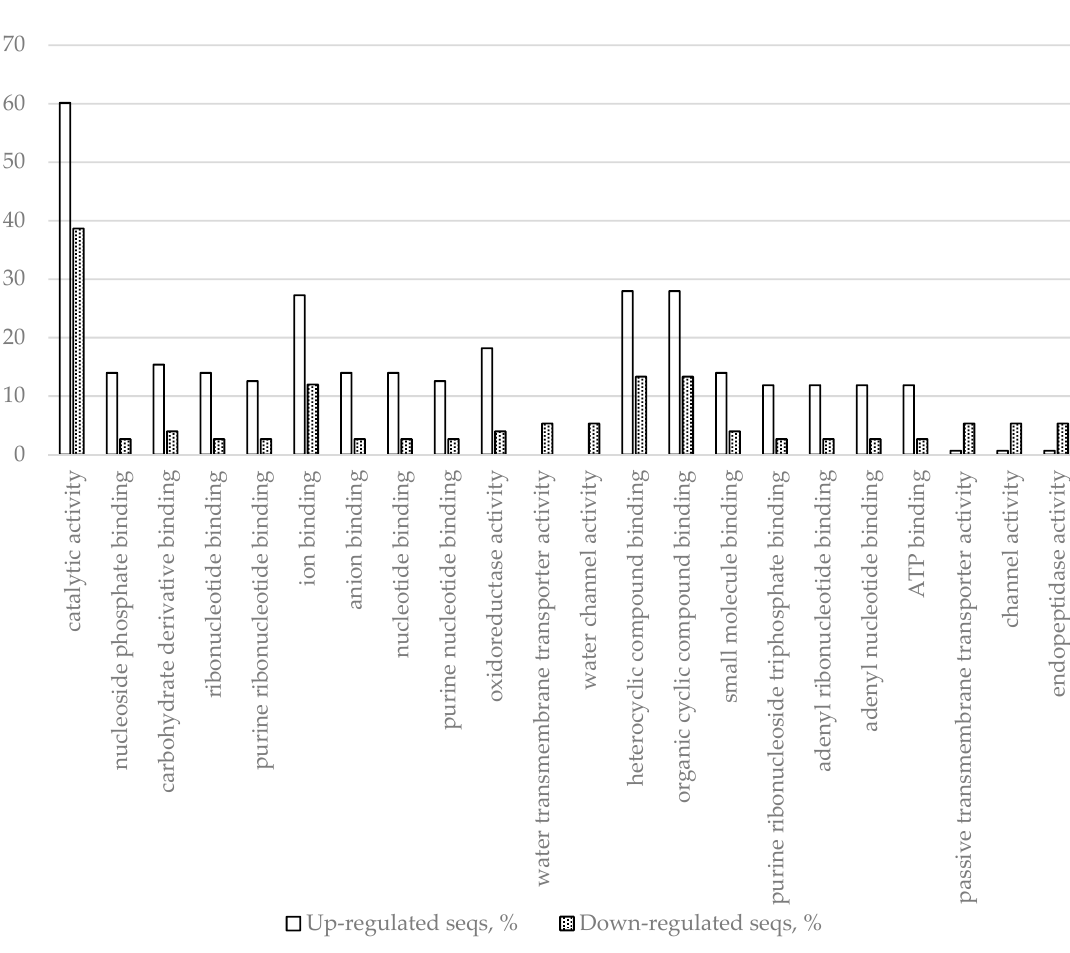
Figure 2. Biological processes with most up- and downregulated differentially expressed genes (DEGs) (inoculation vs. control) determined by Fisher’s exact test using p < 0.05 as the threshold.